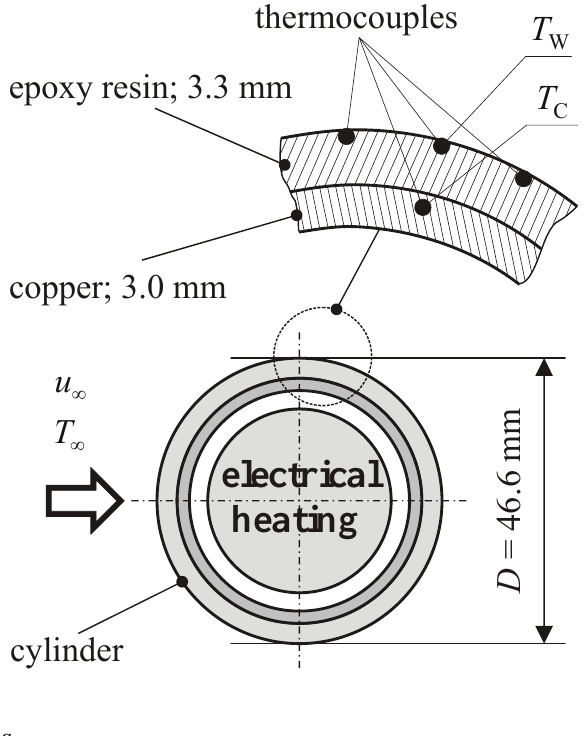
Figure 9. Design of the circular cylinder for local heat flux and wall temperature measurements (comparative